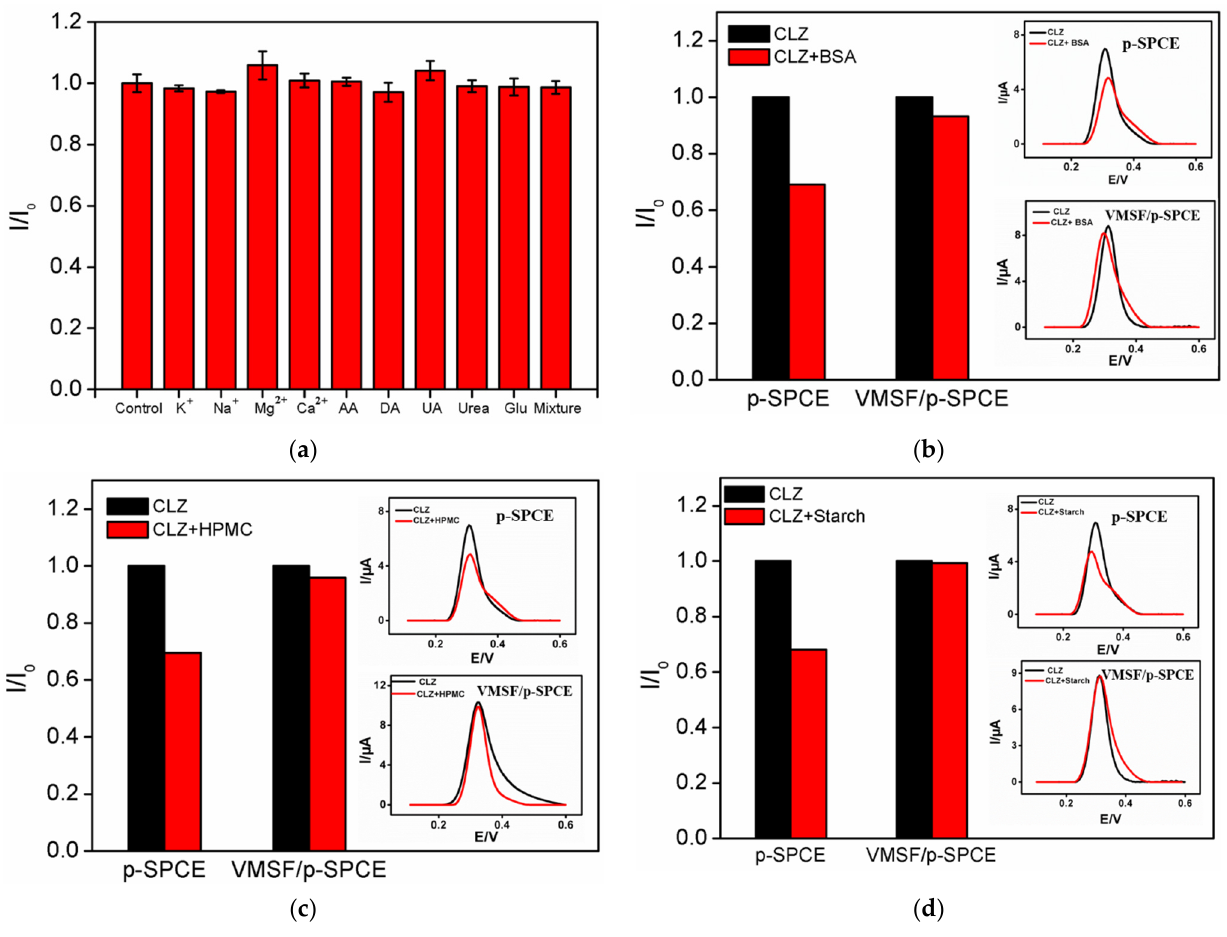
Figure 6. ( a ) The peak current ratio of CLZ on the VMSF/p-SPCE in the absence ( I 0 ) or presence ( I ) of the indicated substance or mixtures thereof. ( b – d ) The peak current ratio of CLZ on the VMSF/p-SPCE or p-SPCE in the absence ( I 0 ) or presence ( I ) of BSA ( b ), HPMC ( c ) and starch ( d ). Insets are the corresponding DPV curves obtained using single CLZ (black) or the binary mixture (red).